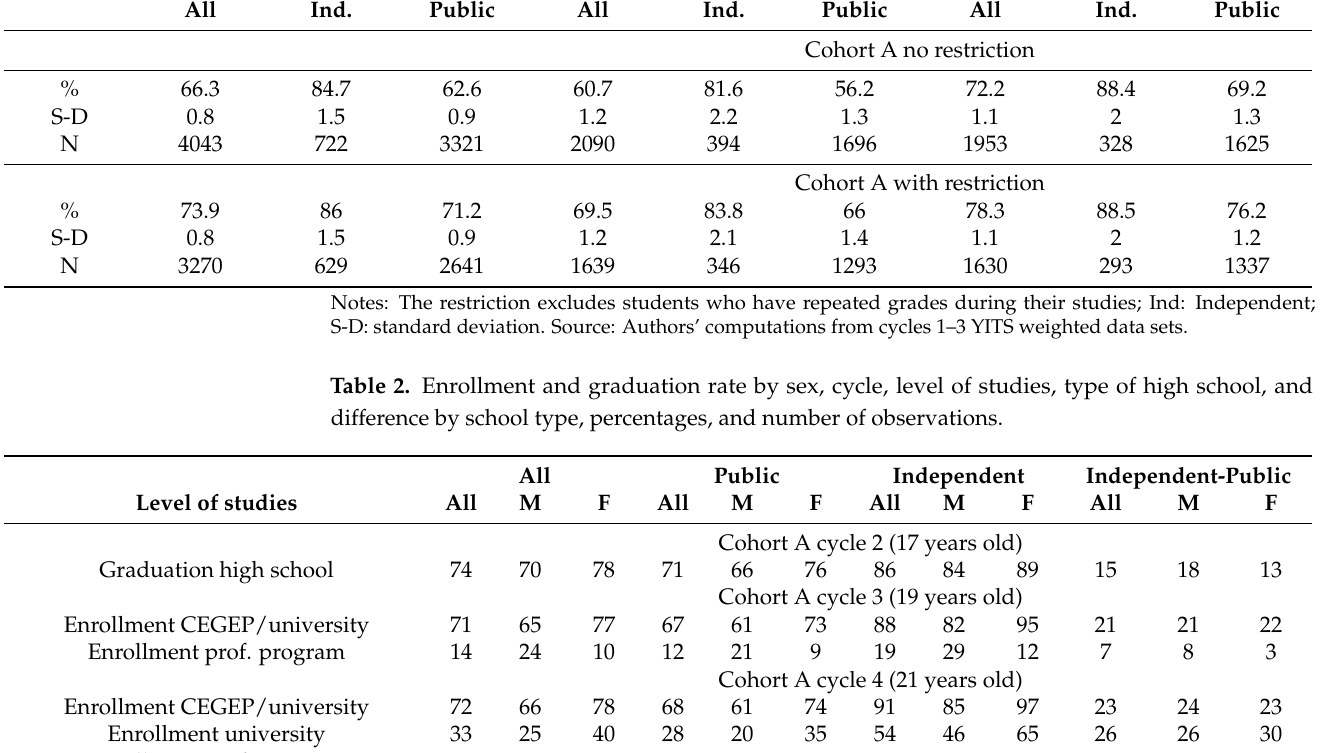
Table 1. High school graduation rate by sex and type of school, cohort A of the YITS. All Male Female All Ind. Public All Ind. Public All Ind.